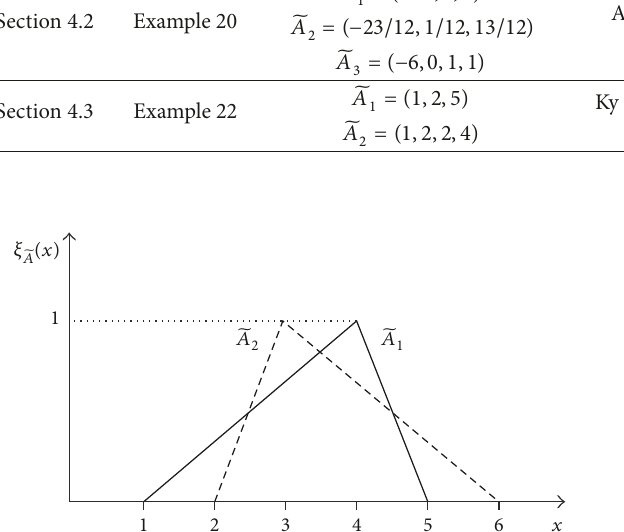
̃𝐴 ̃𝐴 1 and 2 in Example 15.